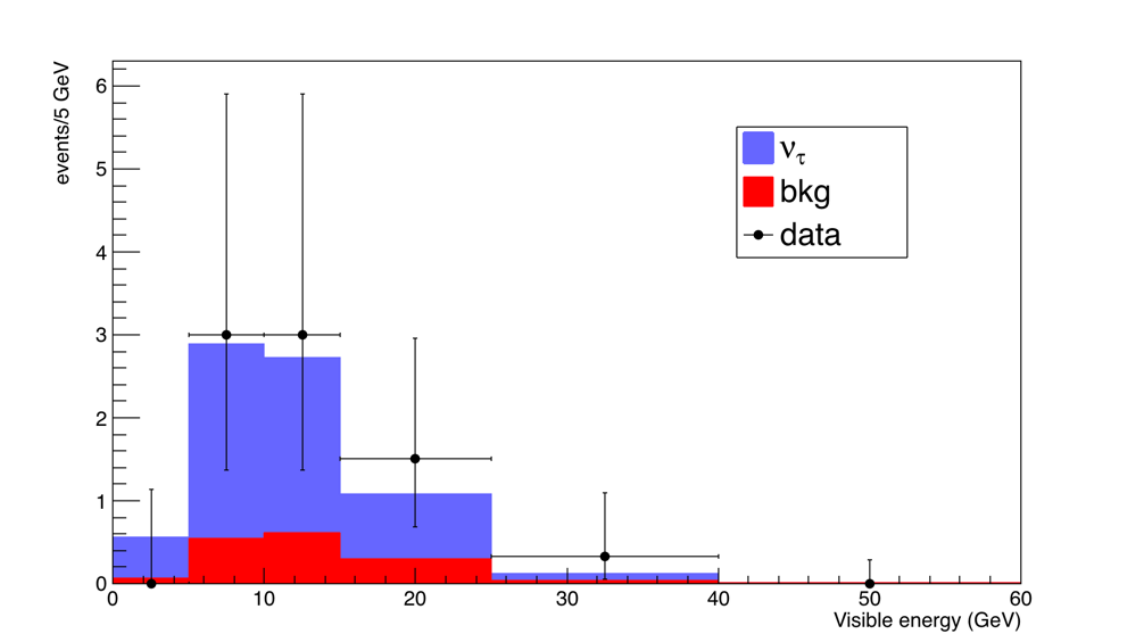
Figure 3. Visible energy distribution of the 10 τ candidates. MonteCarlo predictions for signal and background are also